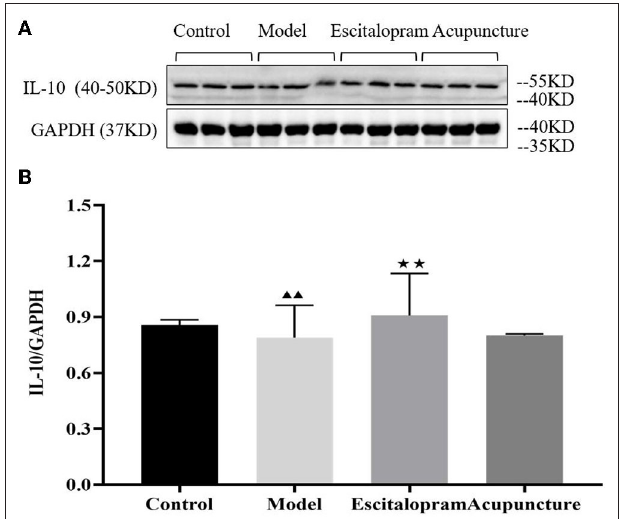
FIGURE 4 | (A) is the protein band diagram of IL-10, and (B) is the bar diagram of IL-10. Effects of acupuncture on the expression of IL-10 protein in the hippocampus of CRS rats. Data are expressed as means ± S.E.M. ( n = 5). NN P < 0.05, compared with control group; ⋆⋆ P < 0.01, compared with model group. One-way ANOVA followed by LSD’s post-hoc test .